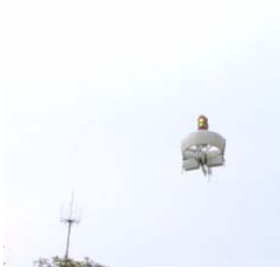
Figure 11. Flight test.